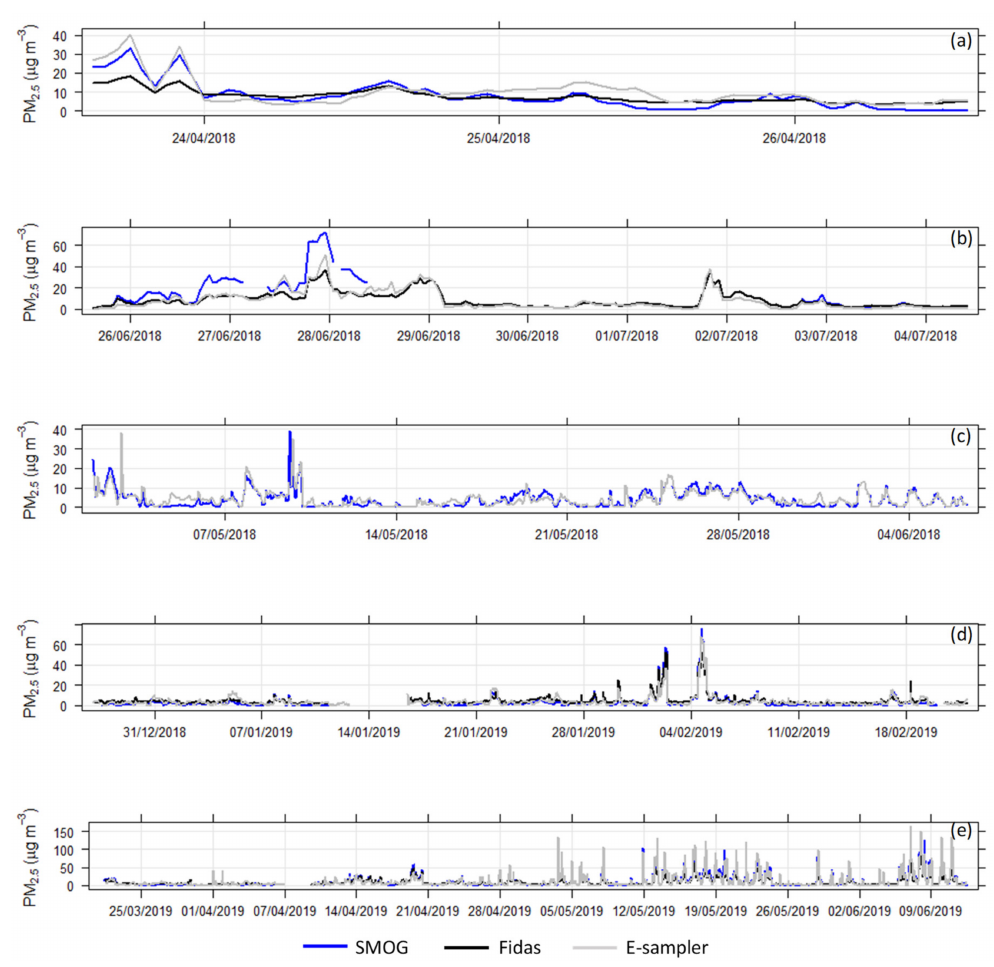
Figure 6. Hourly time series of ambient PM 2.5 concentrations at the four measurement locations in different seasons: ( a ) Aspendale autumn, ( b ) Aspendale winter, ( c ) Rutherglen, ( d ) Alexandra summer, ( e ) Alexandra